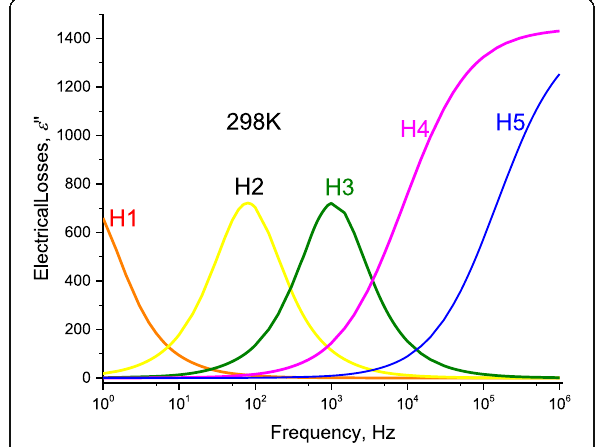
Fig. 16 At 298 K, the electric losses ε ” as a function of frequency for DNA molecule. The relaxation times of H2, H3, H4, and H5 correspond to the maximum frequencies as arrows point out. One can better see the effect of frequency on H1 at lower frequencies in next